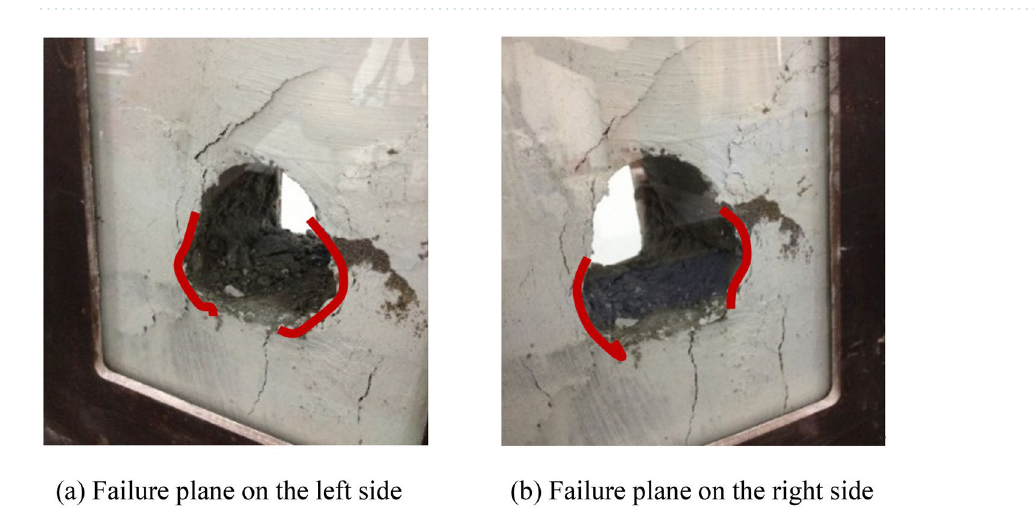
Figure 5. Failure planes of the composite materials tunnel